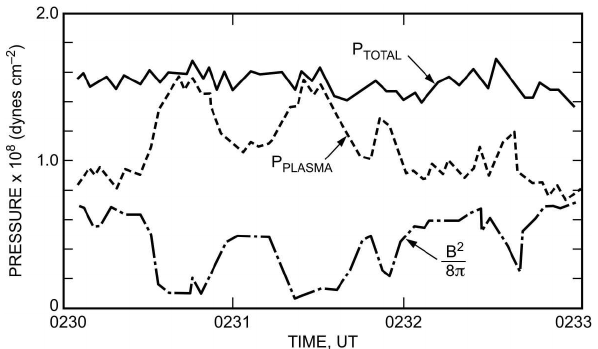
Figure 11 Fig. 11. The plasma and magnetic field partial pressures and the to- tal (plasma plus magnetic field pressure) for several cycles of mirror mode structures.